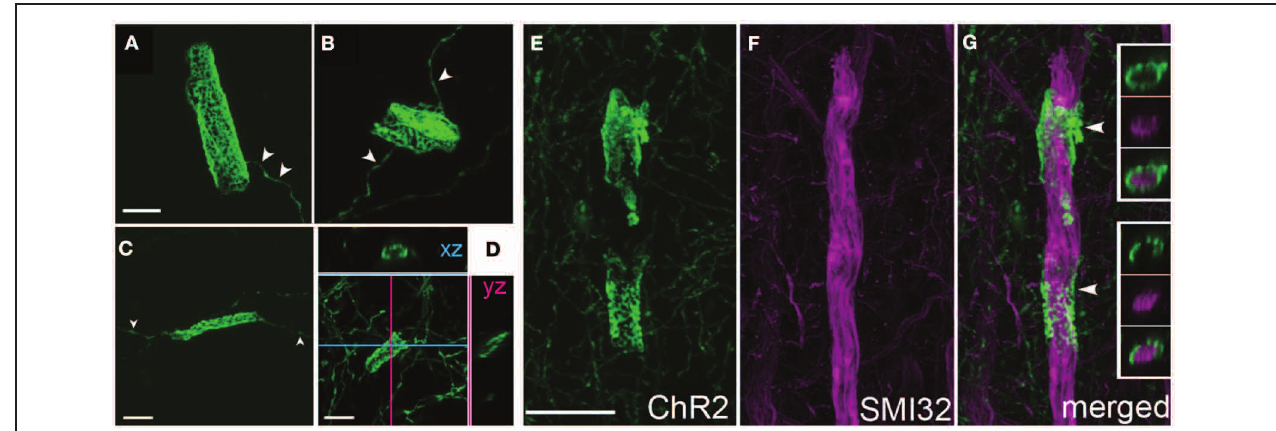
FIGURE 5 | Axonal cylinders. (A–C) Example cylinders, showing patchy, mesh-like fluorescence. Arrowheads, single axon entering and exiting the cylinder. (D) , Confocal sectioning of a cylinder, demonstrating the hollow, tubular structure. Scale bar for (A–D) , 5 μ m. (E–G) , Some axonal cylinders surround pyramidal cell apical dendrites stained by